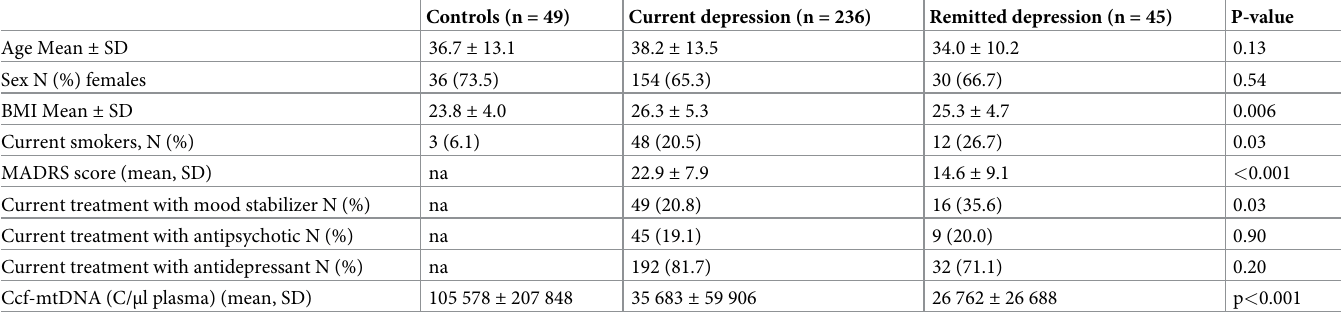
Table 1. Demographic characteristics and ccf-mtDNA in patients and